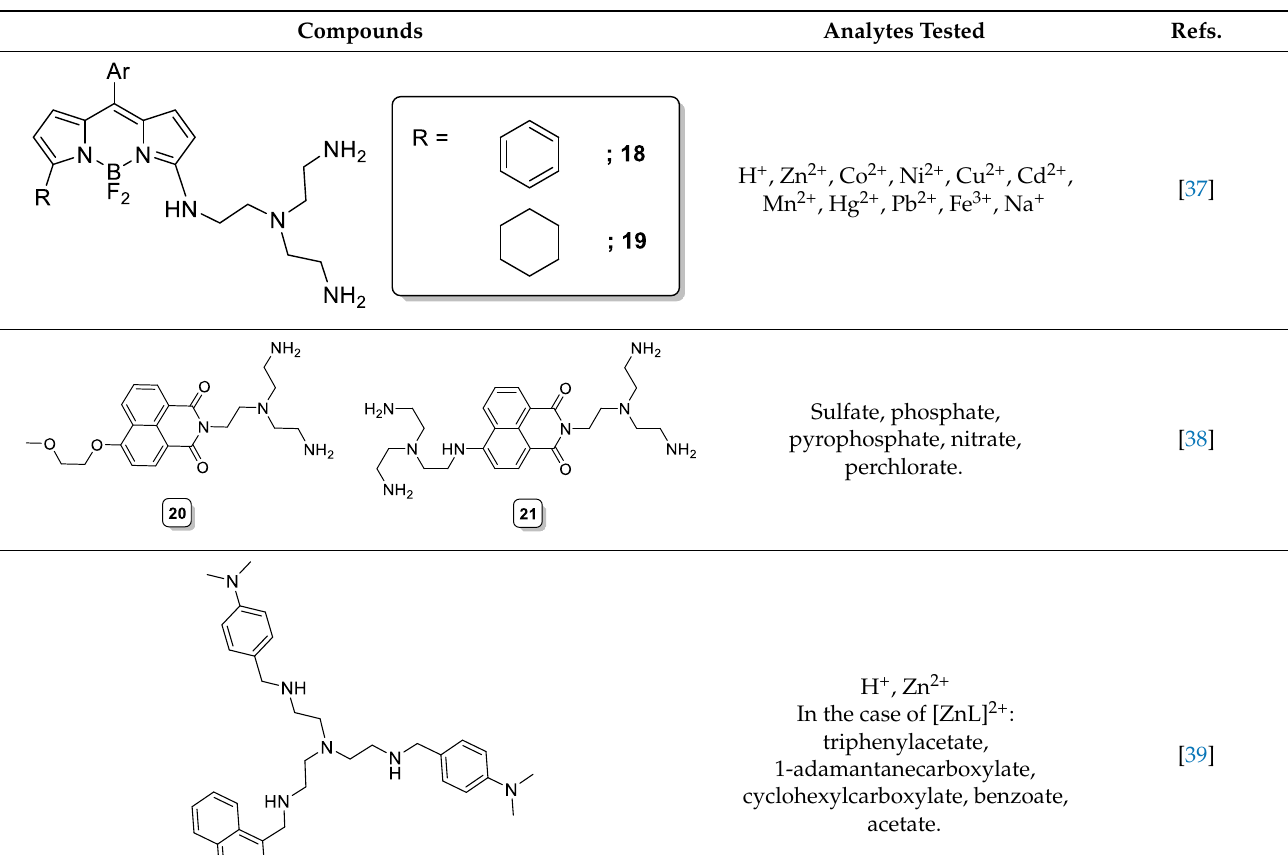
Table A1. Cont. Compounds Analytes